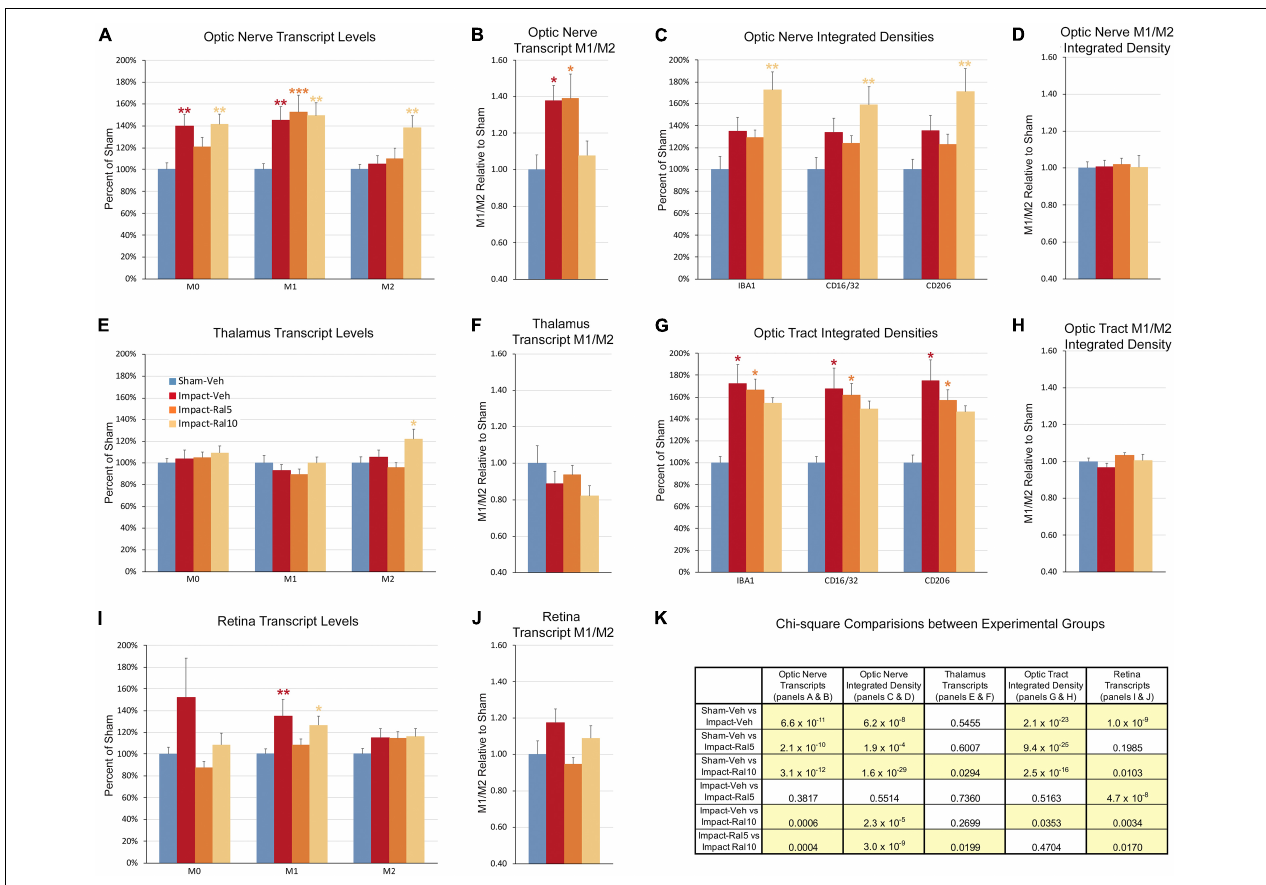
FIGURE 9 | Expression of microglial markers 3 days after impact TBI. Levels of M0, M1, and M2 transcripts were determined by qPCR/NanoString for the optic nerve (A,B) , thalamus (E,F) , and retina (I,J) . Histograms show average levels relative to sham mice or the M1/M2 ratio relative to sham. Multiple immunofluorescence was performed for IBA1, CD16/32, and CD206 on sections of optic nerve (C,D) and optic tract (G,H) and quantified by determining the integrated optical density for each marker in the region of interest. Histograms show the total integrated density relative to sham or the M1/M2 ratio relative to sham. Red, orange, and yellow asterisks indicate significant differences between the impact-vehicle mice, impact-ral5 mice, and impact-ral10 mice, respectively, compared to the sham-vehicle mice; * p < 0.05, ** p < 0.01, *** p < 0.001. (K) Chi-square analysis of mean M0 transcript levels or IBA1 integrated optical density, mean M1 transcript levels or CD16/32 integrated optical density, and mean M2 transcript levels or CD206 integrated optical density, and the M1/M2 ratio was used to compare across experimental groups to determine how these four endpoints (M0 marker, M1 marker, M2 marker, and M1/M2 ratio) differed as a set for each of the tissues examined. Comparisons yielding p < 0.05 are highlighted in